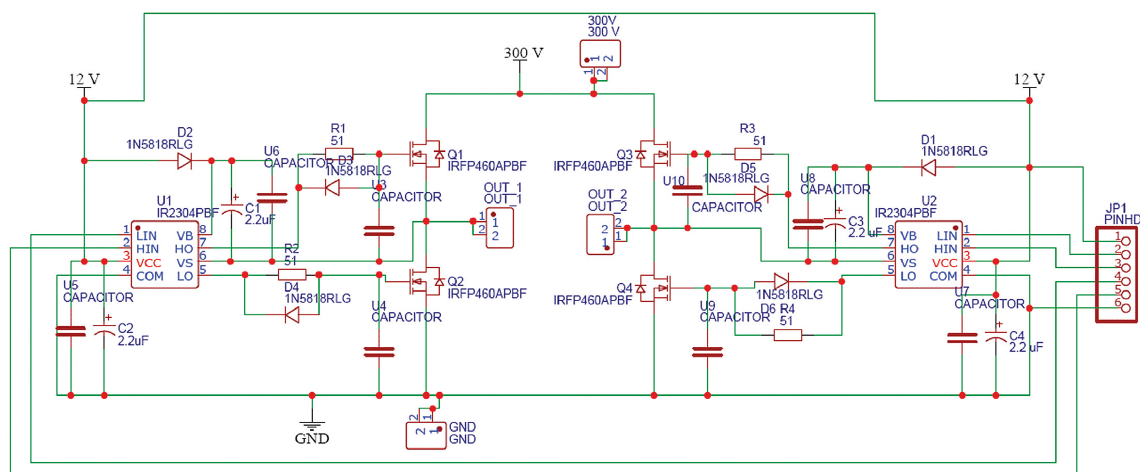
Figure 11: The H-bridge drive circuit fed from the PWM controlled Arduino signal.